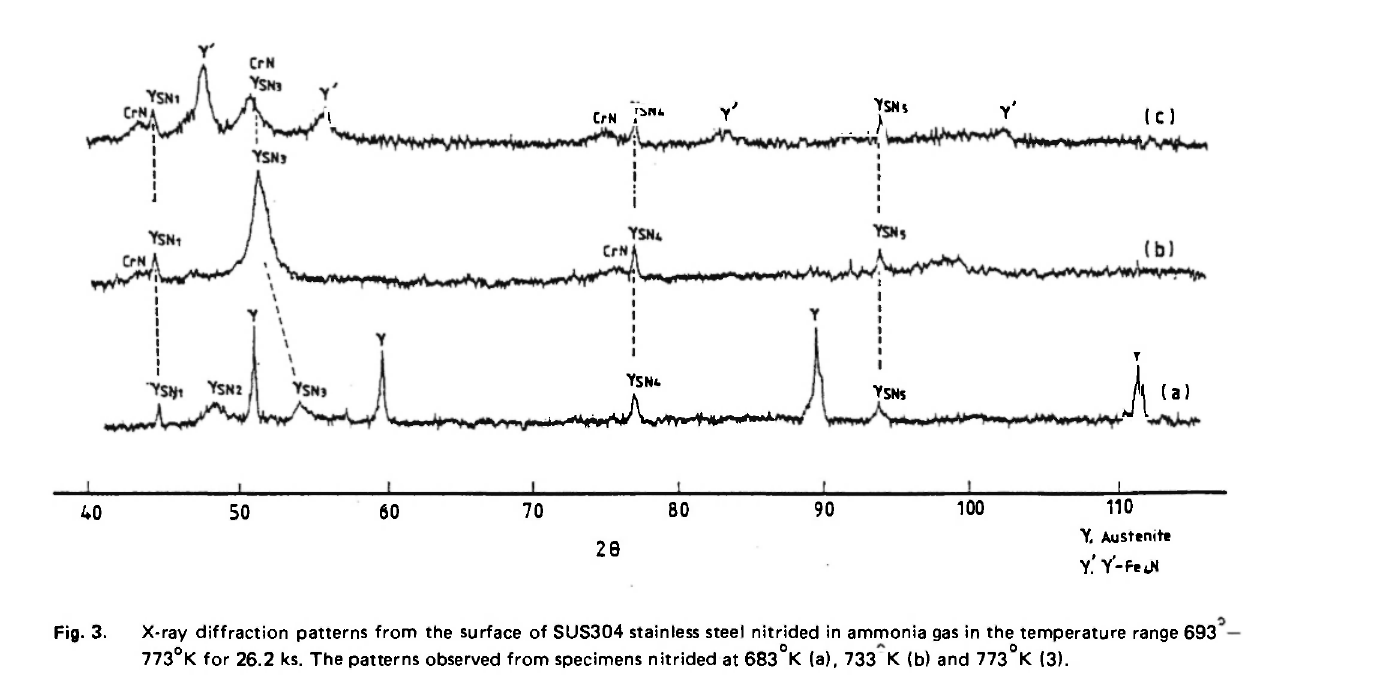
X -ray diffraction patterns from the surface of SUS304 stainless steel nitrided in ammonia gas in the temperature range 693 773°K for 26.2 ks. The patterns observed from specimens nitrided at 683°K (a), 733 Κ (b) and 773°K (3).